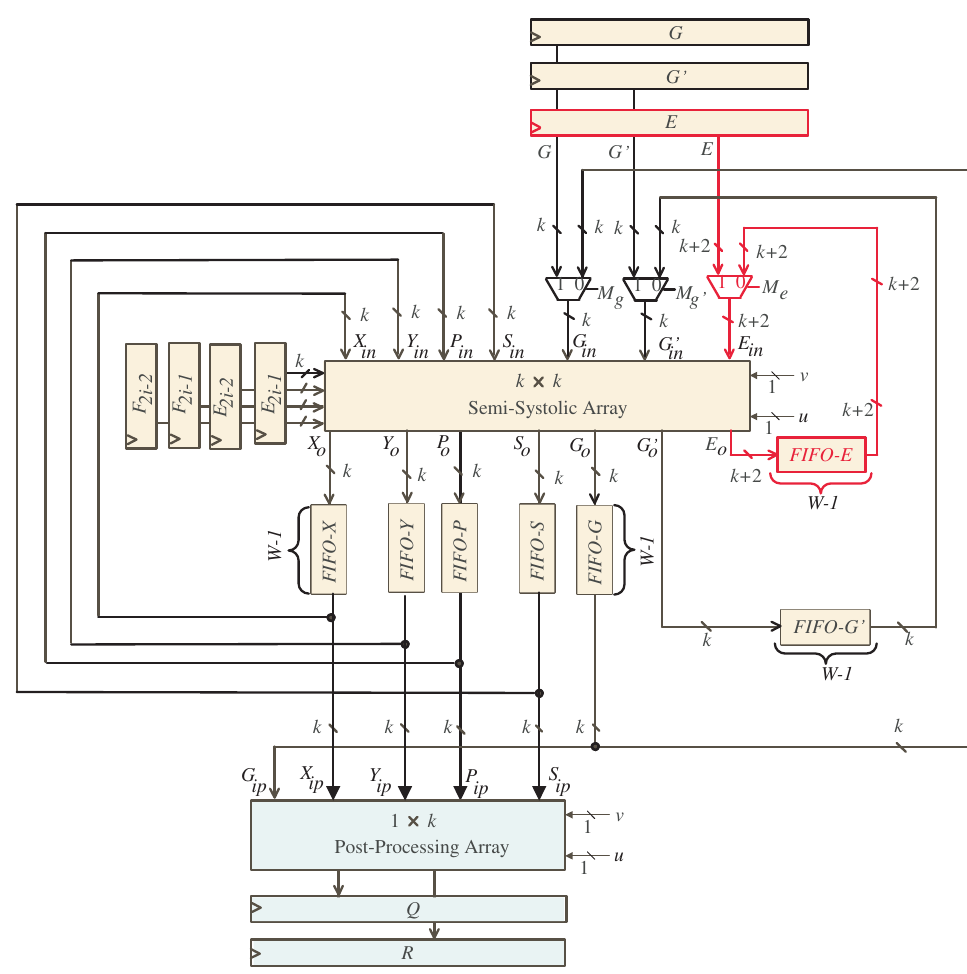
Figure 5. Word-based SISO semisystolic